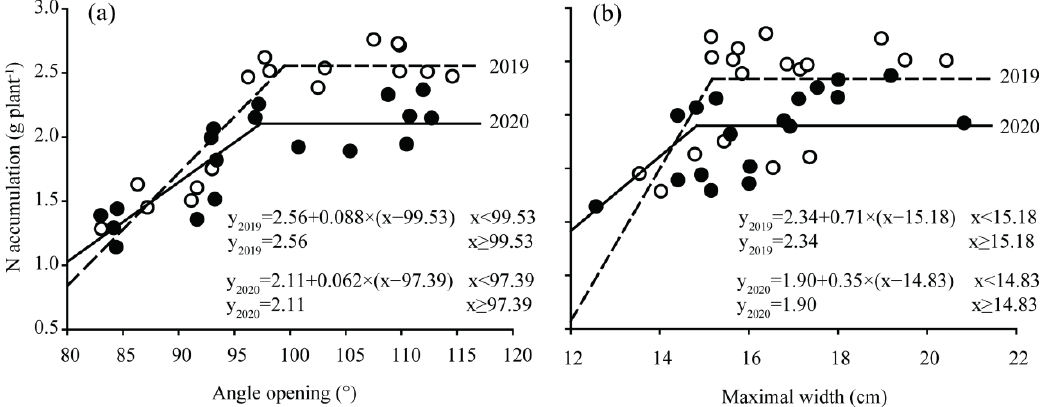
Figure 8. Relationship among angle opening, maximal width, and N accumulation in six maize cultivars under three different N treatments. ( a ) Relationship between root angle opening and N accumulation, ( b ) Relationship between root maximal width and N accumulation.The white and black cicles represent the 2019 and 2020 values, respectively. * significant at p < 0.05, ** significant at p < 0.01.